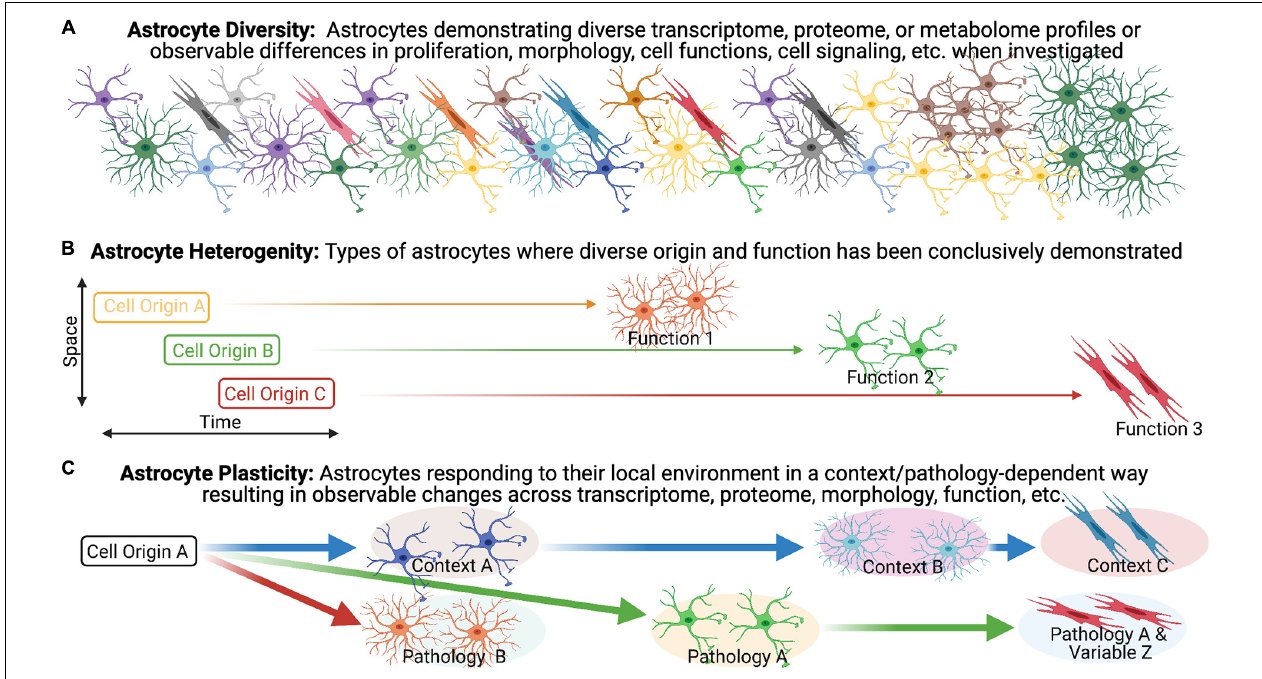
FIGURE 1 | Astrocyte heterogeneity vs. astrocyte plasticity. (A) Evidence for diversity within the astrocyte population is becoming increasingly recognized and is particularly robust in the context of pathology/disease. (B,C) We highlight the importance of distinguishing astrocyte heterogeneity from astrocyte plasticity, as we define them, to direct our understanding of reactive astrogliosis and inform potential